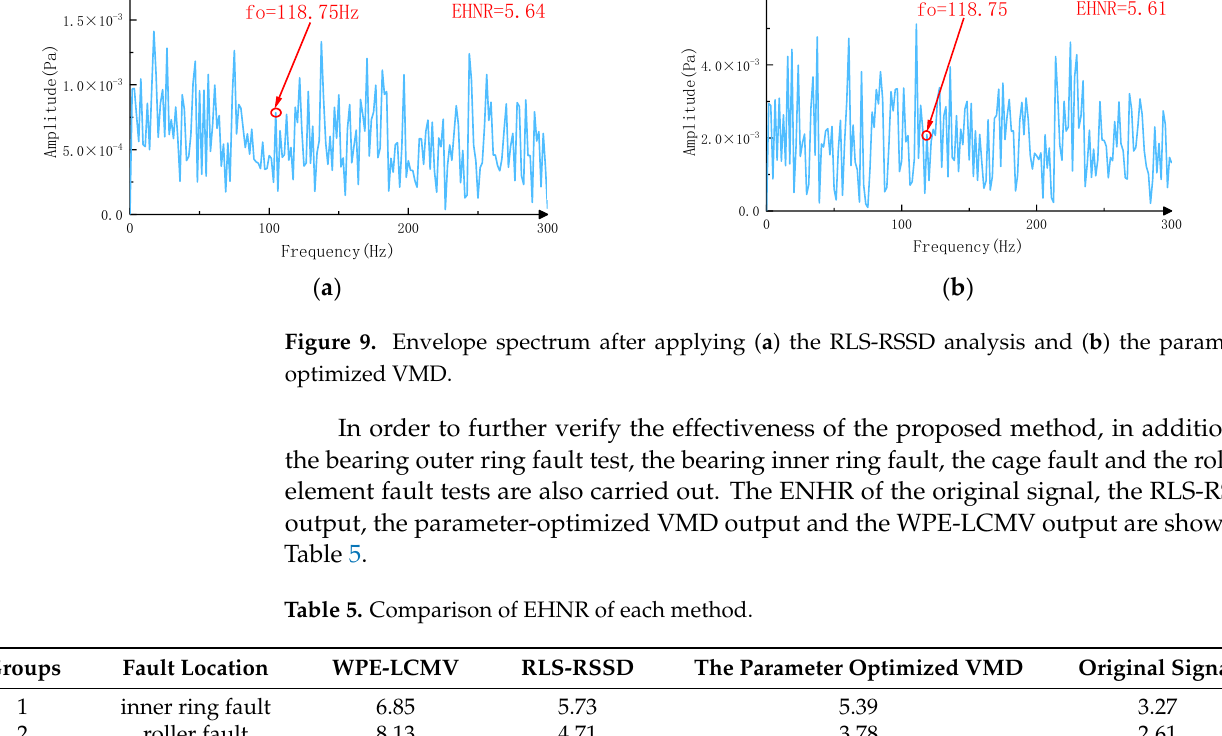
Figure 8. The envelope spectrum of ( a ) the first microphone original signal and ( b ) after WPE-LCMV analysis. The RLS-RSSD and the parameter-optimized VMD methods are used to analyze the bearing outer ring fault signal, and the envelope spectrum as shown in Figure 9.